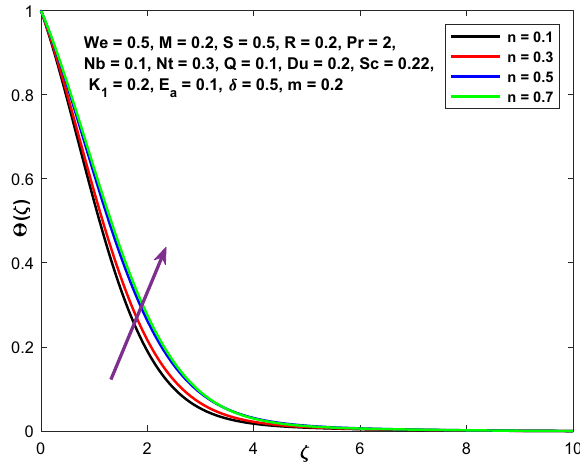
Figure 10. Character of n versus �(ζ) .